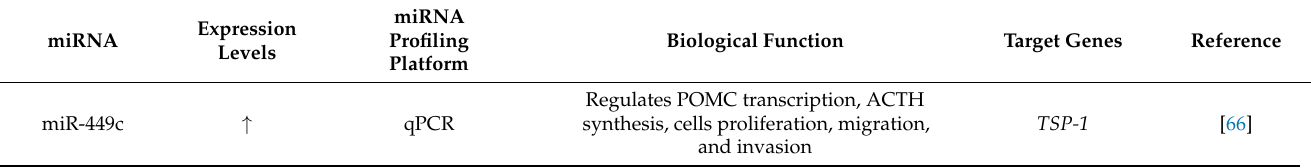
Table 5. Summary of differentially expressed miRNAs with their validated targets in corticotropinomas.